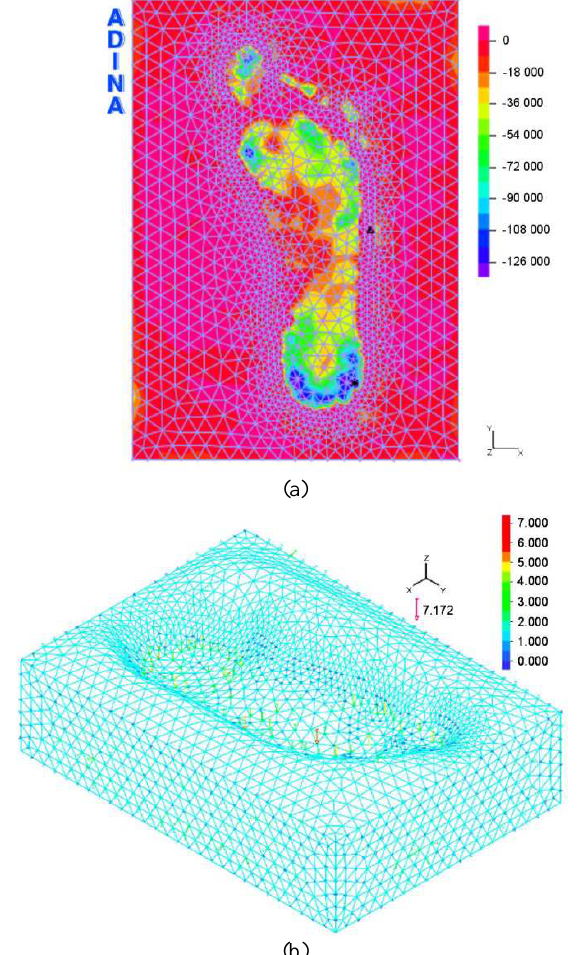
Figure 7. Distribution of the vertical stress component on the top surface [Pa] (a), the mesh deformed [N]